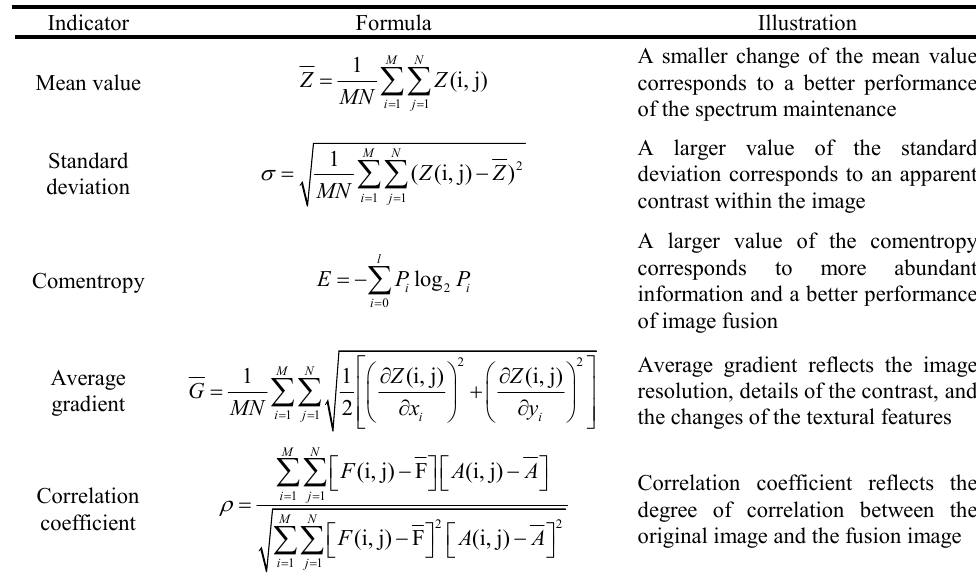
Table 2. The evaluation indicators for the fusion performance